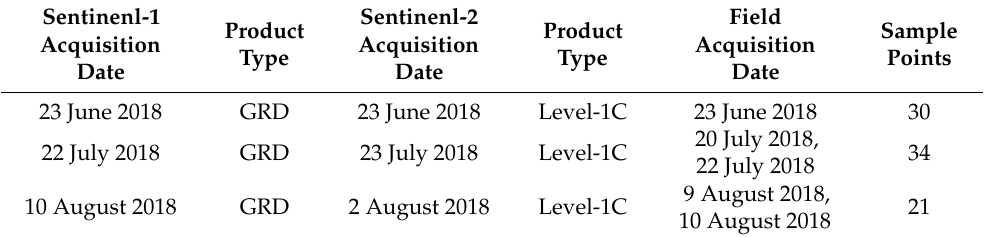
Table 1. Details of Sentinel-1, Sentinel-2 images, and field samples acquired for the